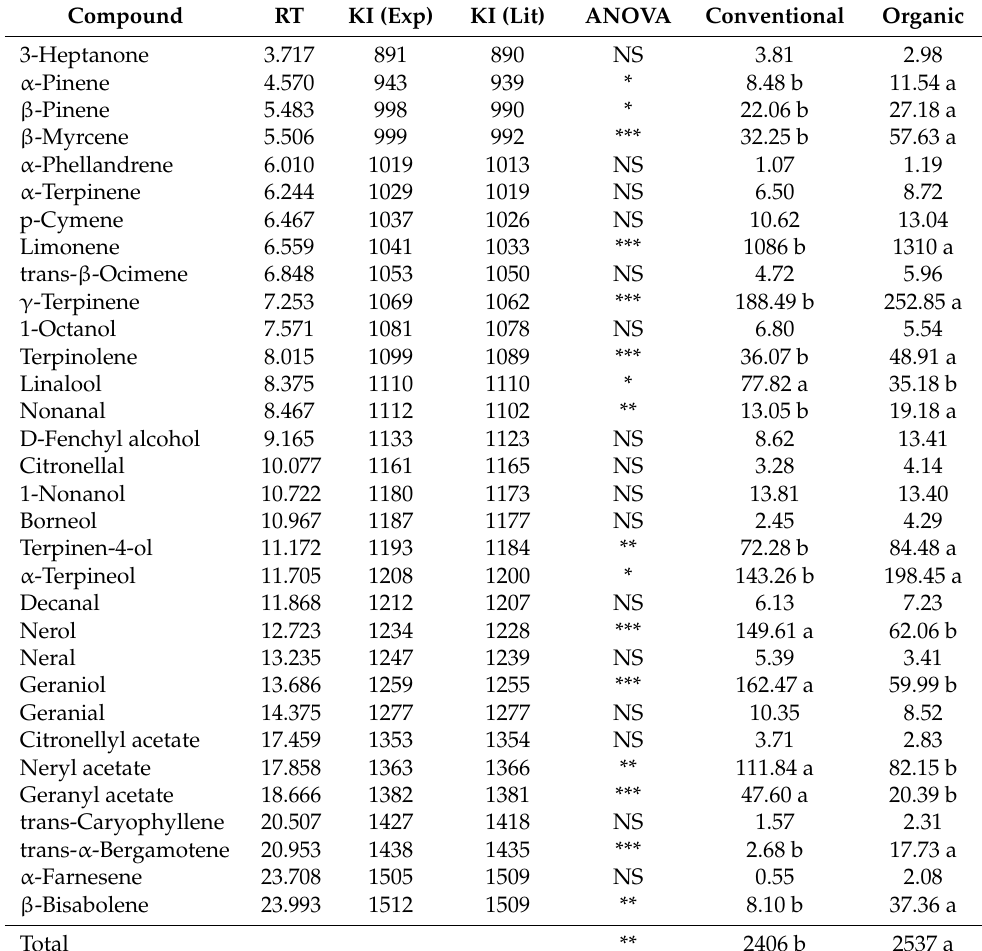
Table 5. Concentrations (mg L − 1 ) of volatile compounds in lemon juice “Fino 49” cultivated under organic and conventional farming.